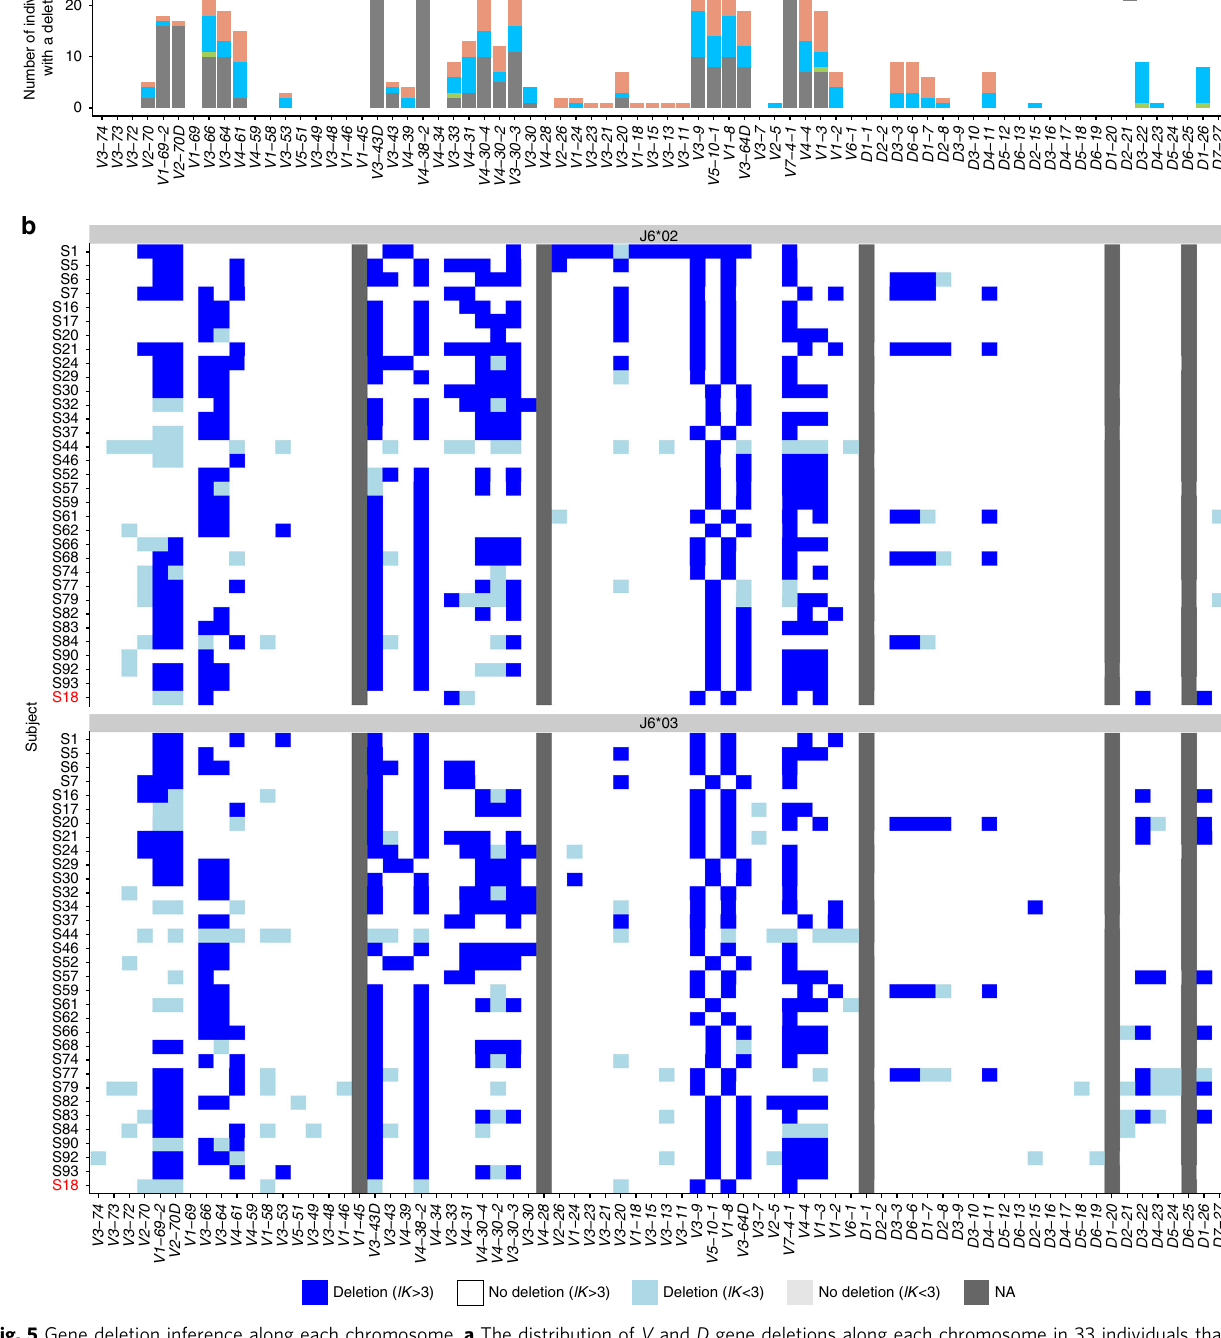
Fig. 5 Gene deletion inference along each chromosome. a The distribution of V and D gene deletions along each chromosome in 33 individuals that are heterozygous for J6 , as inferred by haplotype (light red, blue, and green) and by the binomial test (gray). b A heatmap of V and D gene deletions and suspected deletions for each of the 33 heterozygous individuals in J6 . Each row represents an individual, and each column represents V or D gene. Blue represents a deletion ( lK > 3), light blue represents a suspected deletion ( lK < 3), and light gray represents no deletion on both chromosomes with low certainty ( lK < 3). Dark gray represents a gene with an extremely low usage across all samples. The top panel represents the chromosome on which J6*02 is present, and the bottom panel represents the chromosome on which J6*03 is present. Sample S18, marked in red is heterozygous for J6*03 and J6*04 . For this individual, J6*04 was added to the J6*02